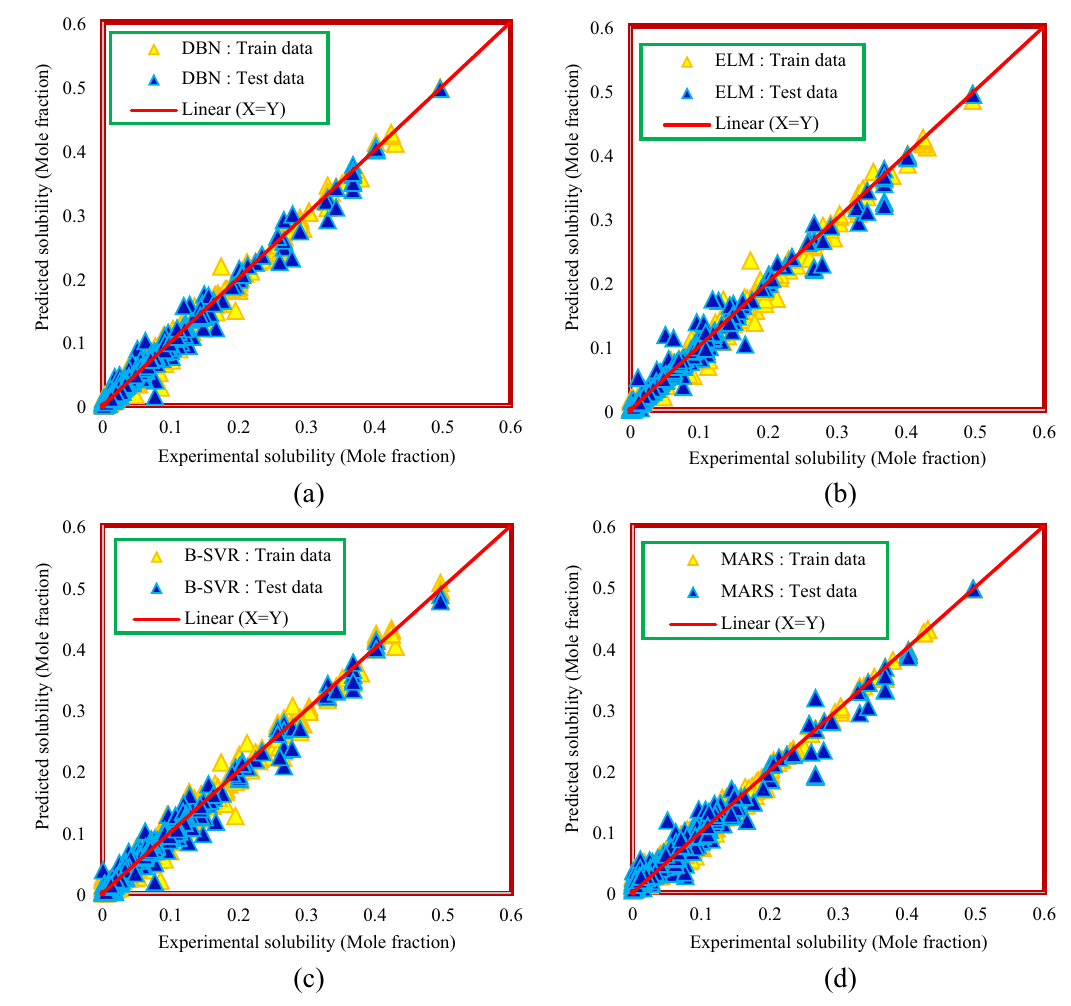
Figure 9. Cross plot diagram of the results of Model (II): ( a ) DBN model, ( b ) ELM model, ( c ) B-SVR model, ( d ) MARS